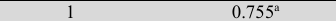
Multiple Linear Regression Analysis: R-Square Test Result Model